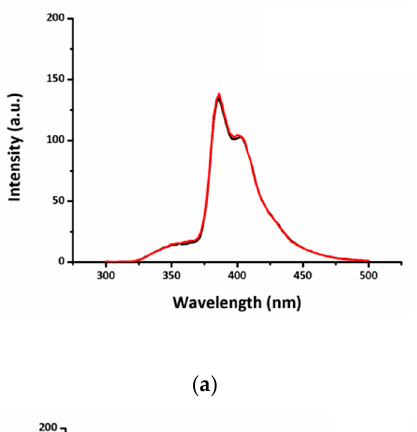
( b ) Figure 1. Fluorescence emission intensities of 2a – e ( λ ex according to Table 1) ( a ) at various pH values and ( b ) at various dissolved coumarin concentrations in DMSO/HEPES buffer ( v / v , 1/9). 2.3. UV-Vis and Fluorescence Properties of 2a – e in the Presence of Cu 2+ UV-Vis spectra of 2a – e in DMSO/HEPES buffer ( v / v , 1/9) were recorded upon the addition of one equivalent of CuCl 2 (Figure S21). Coumarins 2a and 2c – e showed no changes in their absorbances, with only 2b showing a broadening of the absorption peak upon addition of CuCl 2 . Recording of the